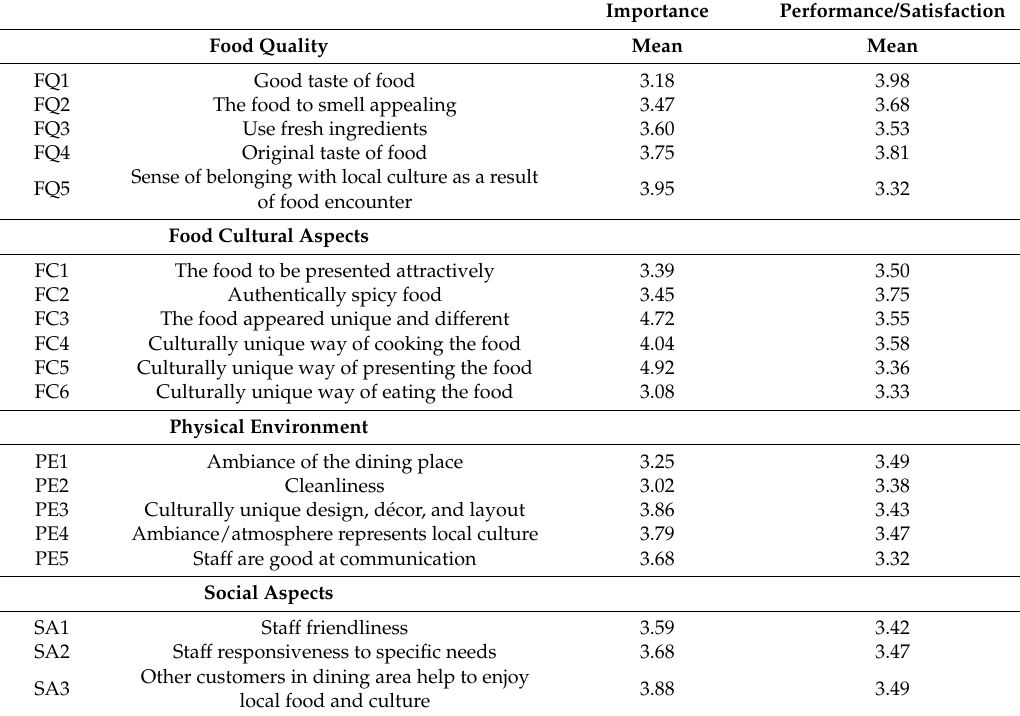
Table 1. Measurement items for local cuisine experience and underlying